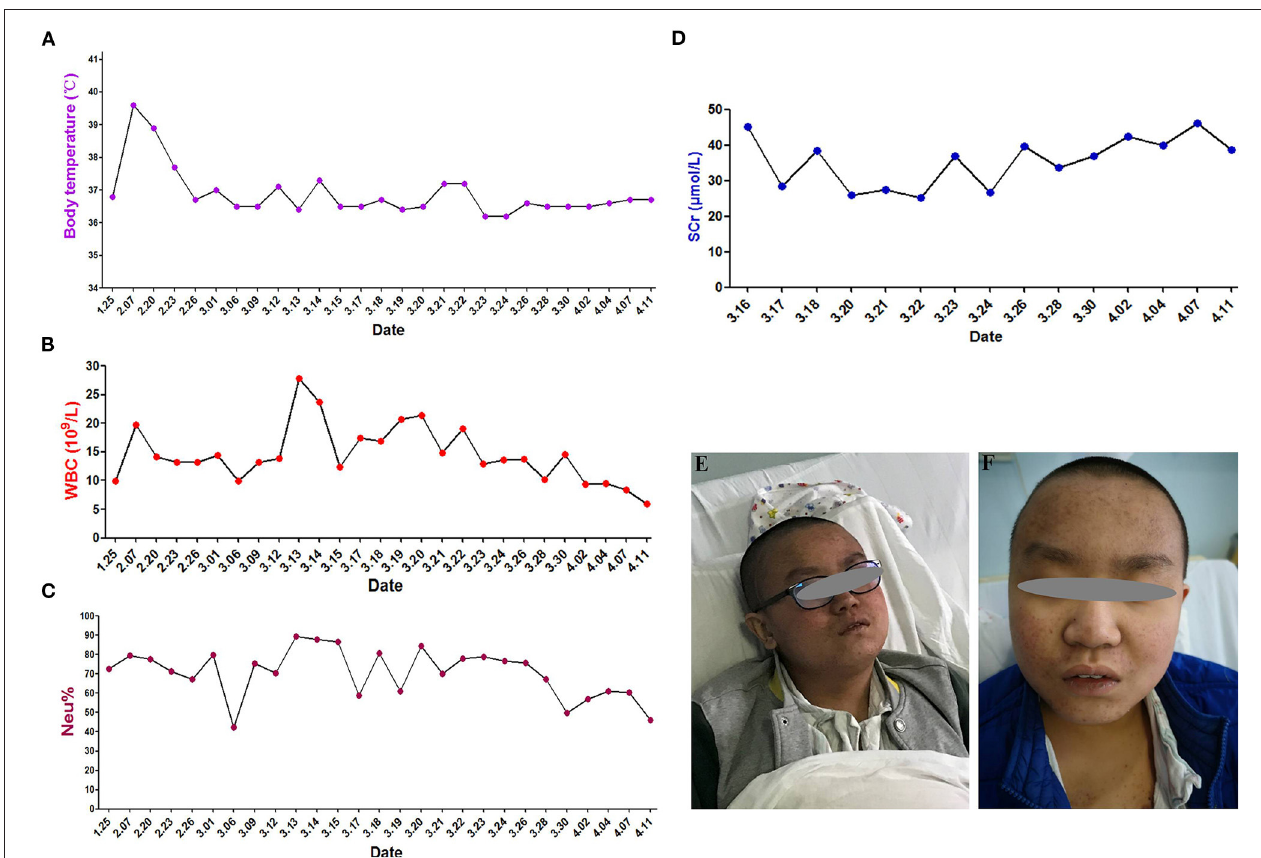
FIGURE 2 | Clinical course and skin hyperpigmentation of the patient. (A) Body temperature over the course of treatment. (B) White blood cell (WBC) count in the peripheral blood. (C) Neutrophil percentage (NEUT%) in the peripheral blood. (D) Serum creatinine (SCr) levels. (E) Skin hyperpigmentation and dark red papule appeared in the upper part of trunk of patient on the fourth day of polymyxin B treatment (March 18, 2019). (F) Skin hyperpigmentation gradually disappeared (January 16,